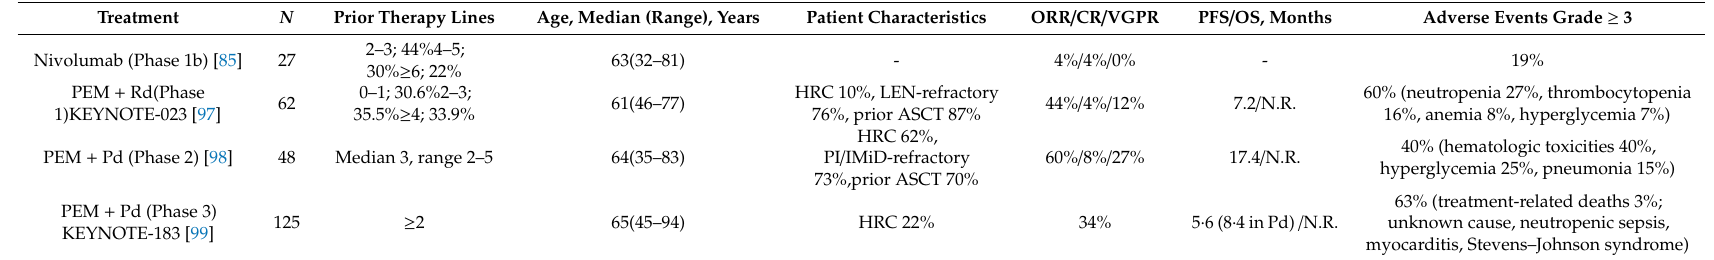
Table 2. PD-1 inhibitors in combination with IMiDs in patients with relapsed / refractory